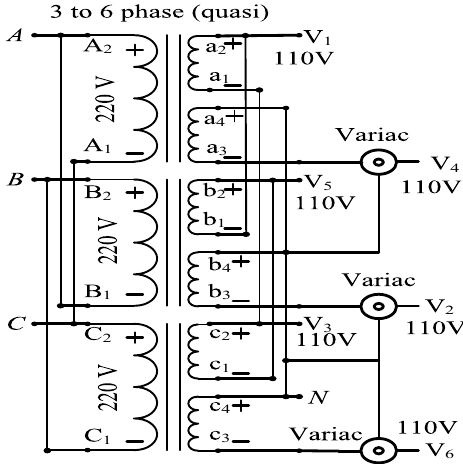
Figure 7. Quasi six-phase output with primary delta; ( a ) connection diagram; ( b ) symbolic representation.